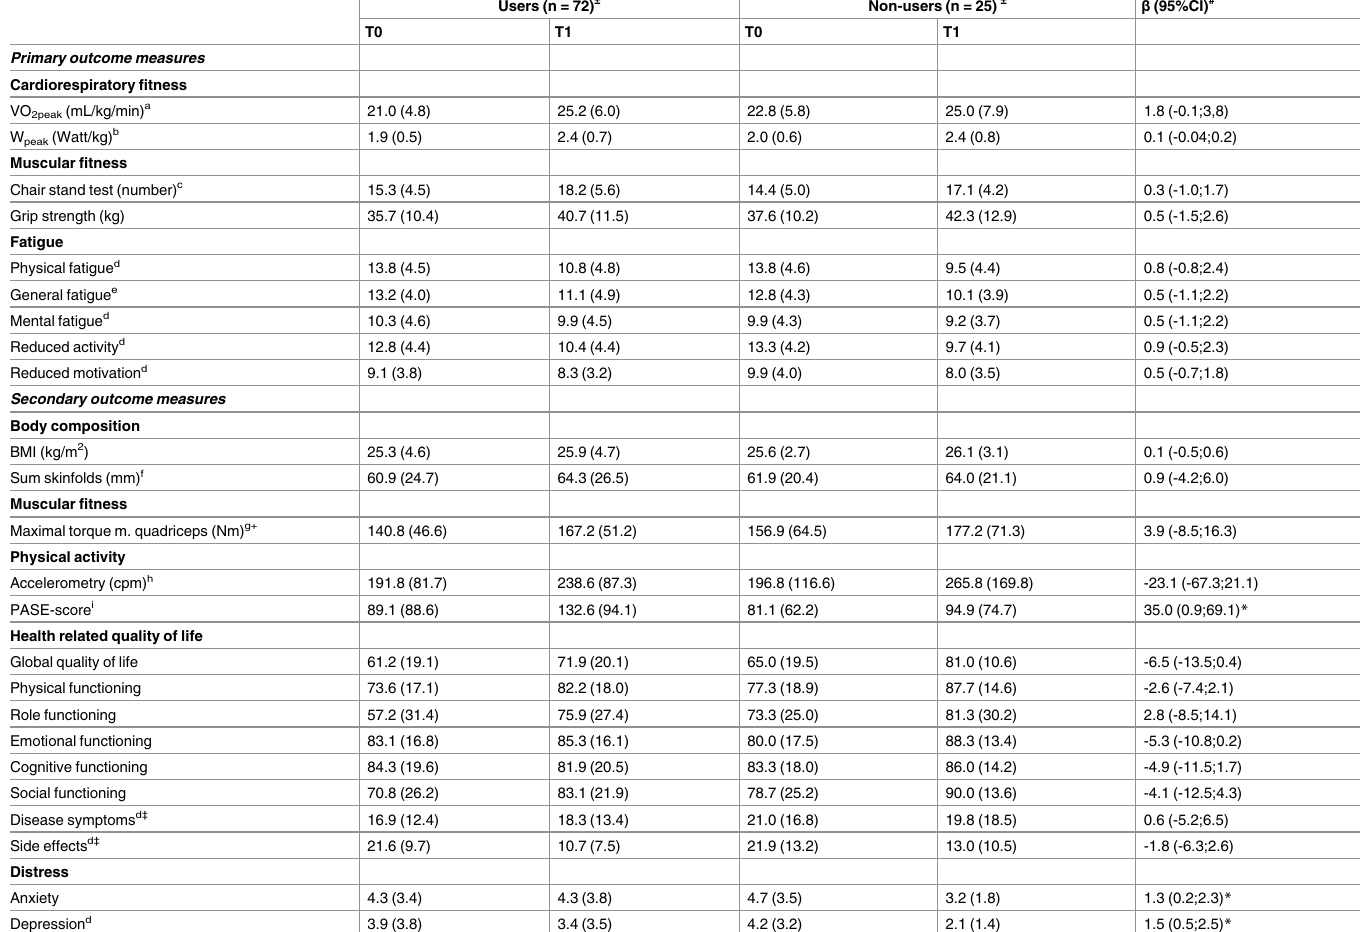
Table 3. Effects of (cid:21) 10 physiotherapy sessions on primary and secondary outcome measures in patients treated with